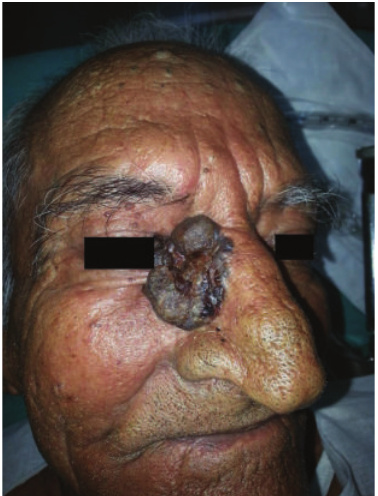
Figure 2: Preoperative image of BCC